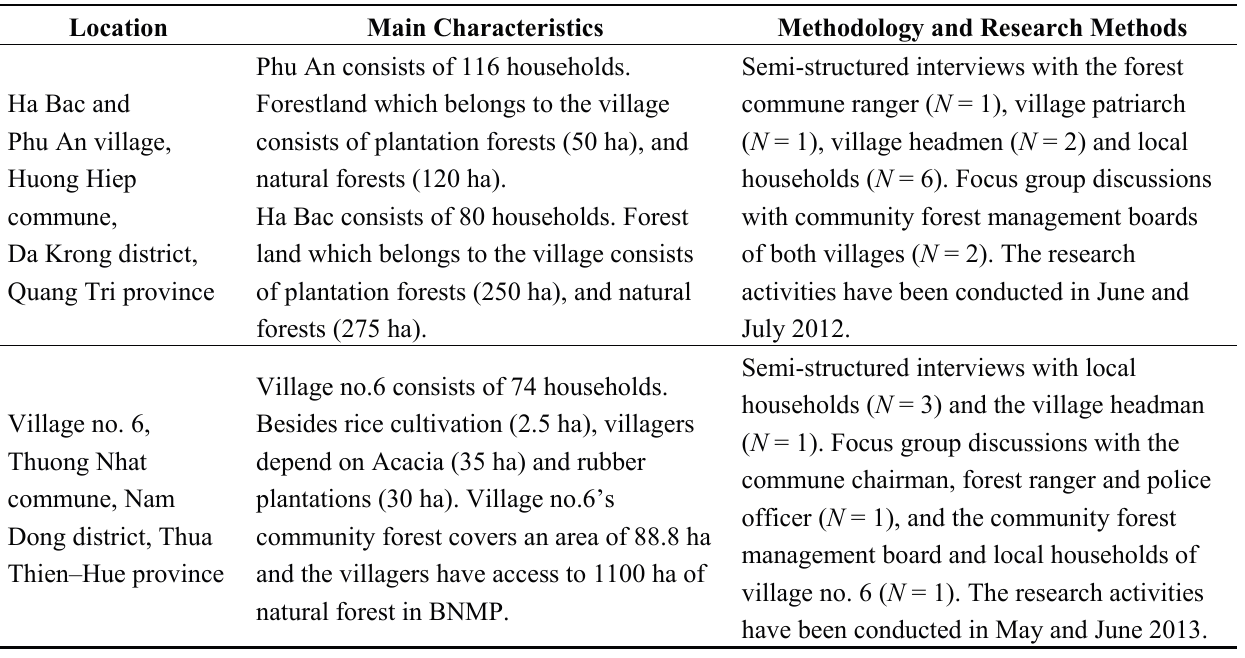
Table 2. The research villages and